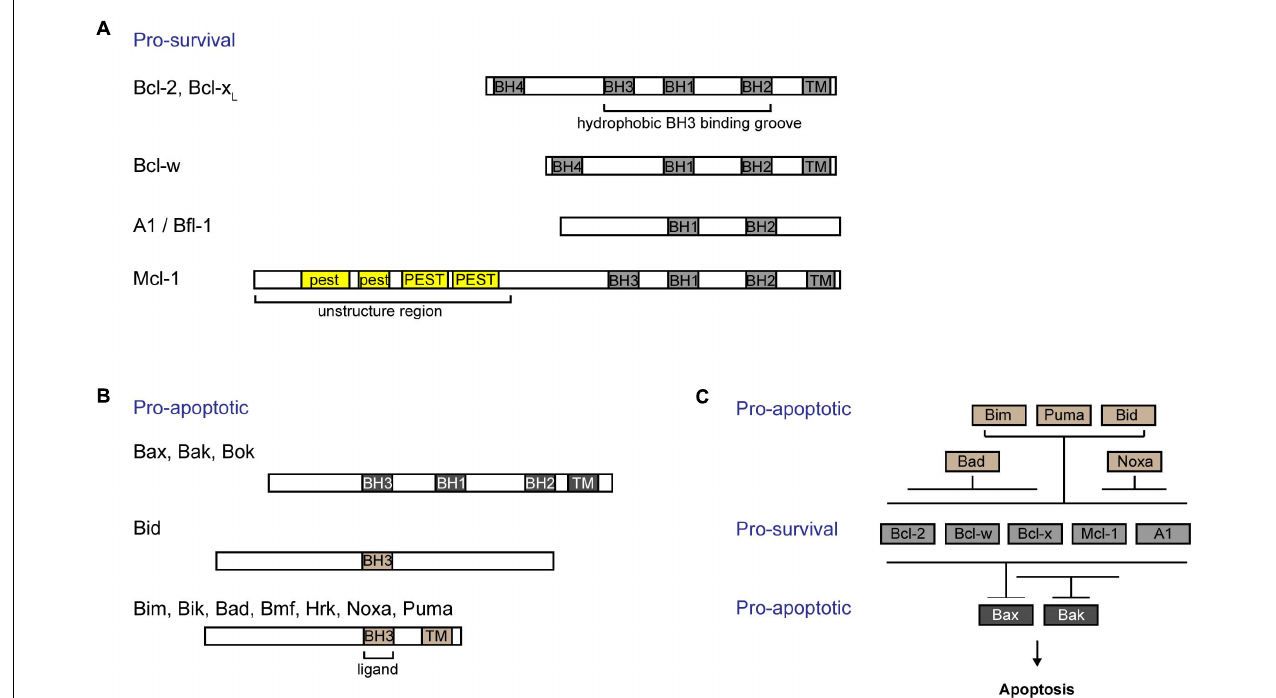
FIGURE 1 | Interactions among Bcl-2 family of proteins confer regulation of the intrinsic apoptotic pathway. Bcl-2 family of proteins are characterized by the presence of Bcl-2 homology (BH) domains. (A) Bcl-2 like pro-survival proteins (Bcl-2, Bcl-x L , Bcl-w, Mcl-1, and A1/Bfl-1) form a hydrophobic groove that interacts with the BH3 domain of pro-apoptotic proteins. The unique Mcl-1 pro-survival protein is labile and contains a 5’ unstructured region with multiple PEST motifs that are targets for post-translational regulation. (B) The pro-apoptotic proteins can be subgrouped into (i) multidomained proteins (Bak, Bax, and Bok) or (ii) BH3-only proteins (Bid, Bim, Bik, Bad, Bmf, Hrk, Noxa, and Puma). (C) BH3-only proteins are activated upon stress signals. While Bim, Puma, and Bid are able to bind to all pro-survival proteins, Bad binds specifically to and neutralizes Bcl-2, Bcl-x L , and Bcl-w, and Noxa binds to A1/Bfl-1 and Mcl-1. Bcl-x L and Mcl-1 preferentially restrain Bak, while all pro-survival proteins are able to bind to Bax. Importantly, all breaks need to be released from Bax and Bak in order for cells to commit to cell